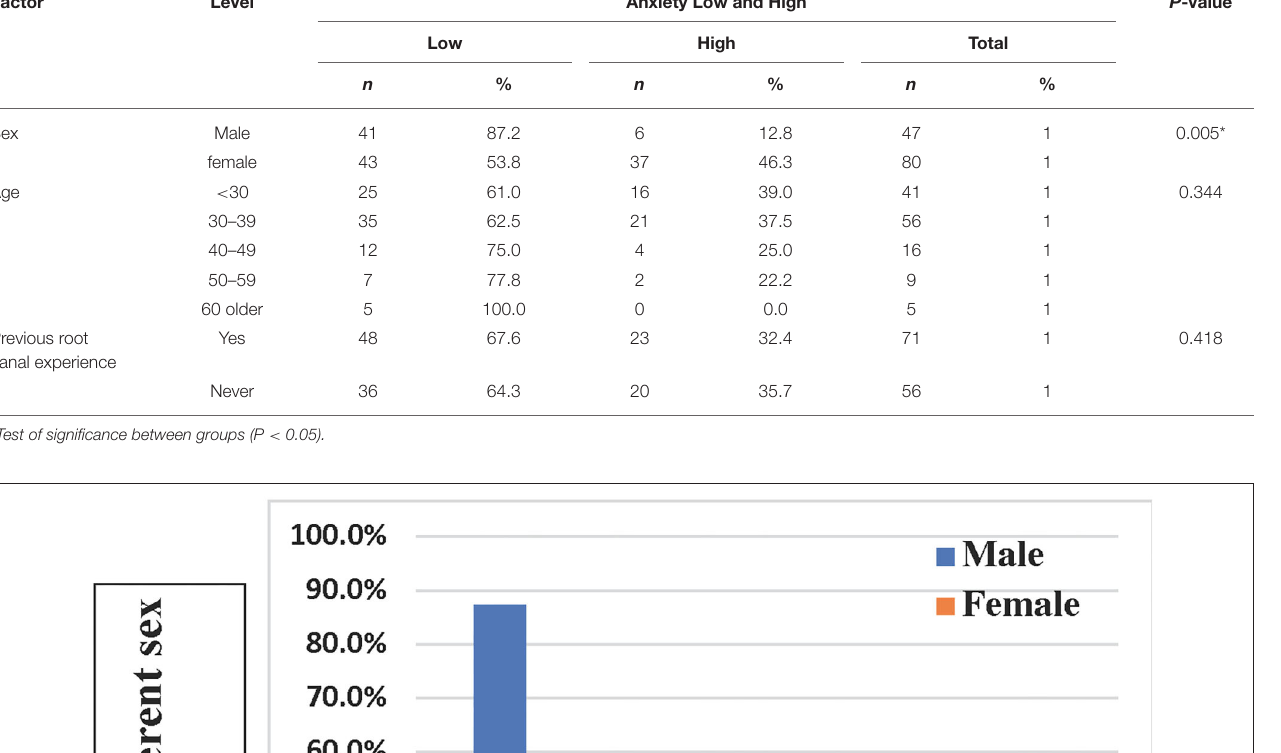
different factors can play a role in dental anxiety and fear specific to endodontic treatment. It appears that root canal